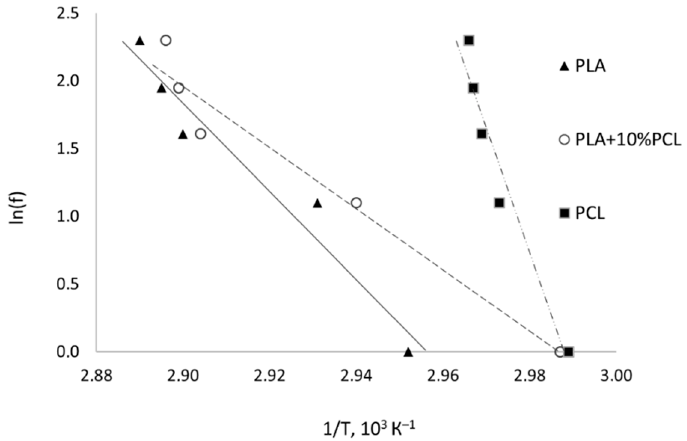
Figure 7. Arrhenius plot of glass transition for the PLA, PLA + 10%PCL, and PCL sam- ples. Table 2. Determination of the apparent activation energy ( E a ) of glass transition by DMA for the PLA, PLA + 10%PCL, and PCL samples.